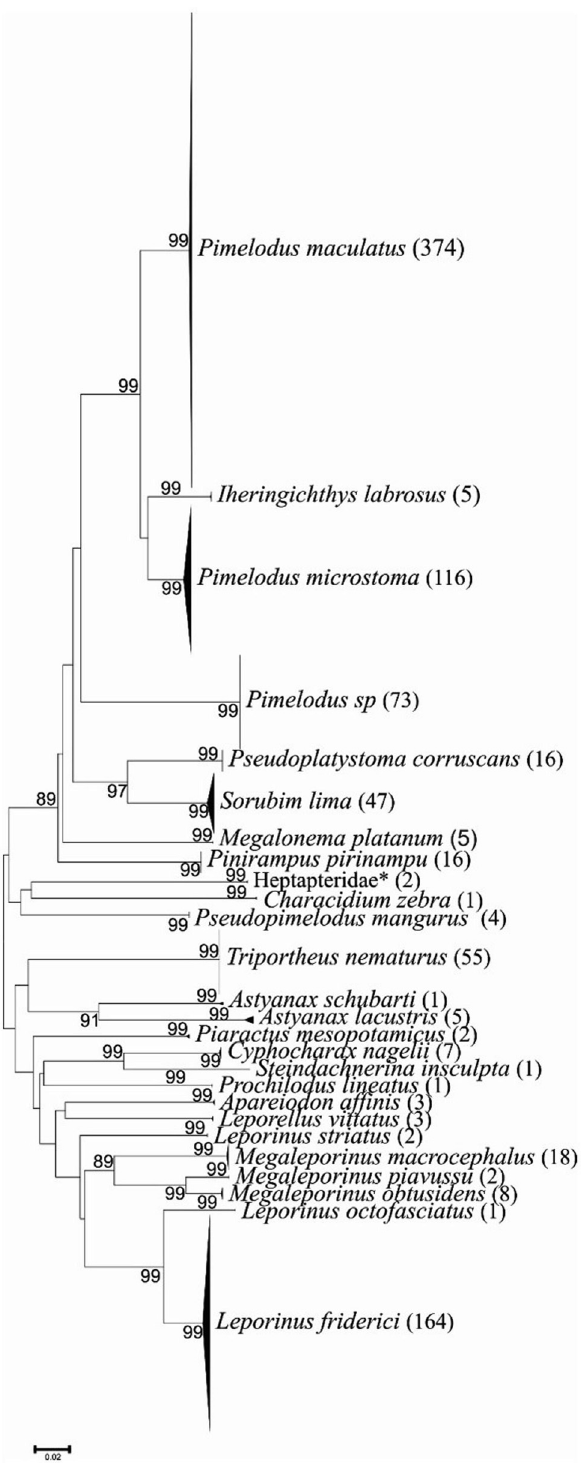
Figure 2 - Dendrogram of genetic distances of species found. The Ki- mura-2-Parameters genetic distance related to the Neighbor-Joining method with 1000 pseudoreplicates using MEGA v6.0 software . Sus- tainability values of the branches are presented next to the nodes at each fork; values below 70% were hidden. The group names in italics indicate the lowest possible taxonomic level, and absolute abundance is indicated in parentheses. (*) Species for which sequences are not deposited in